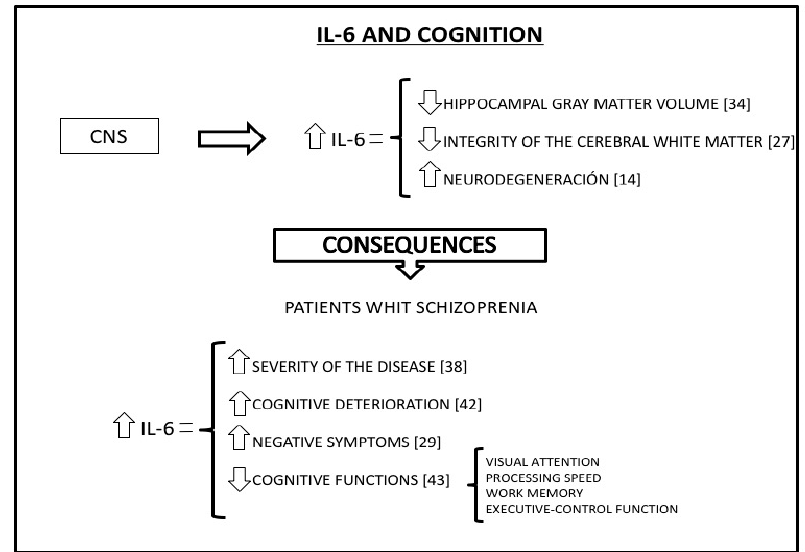
Figure 2. IL-6 has numerous effects in the central nervous system (CNS). These effects have different consequences in the patients with